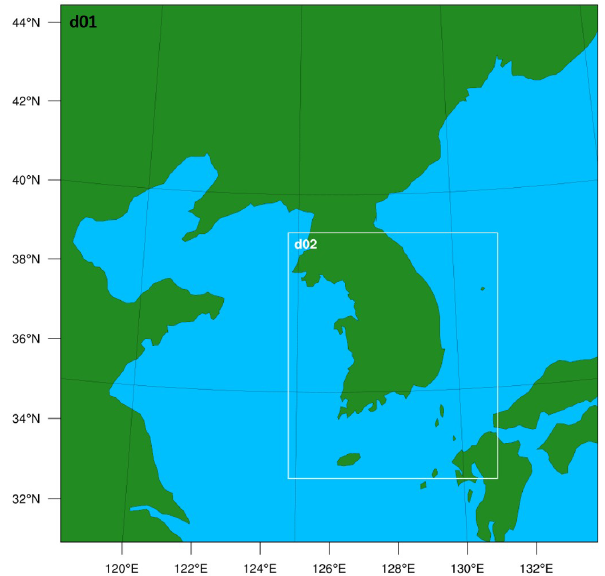
Figure 2. WRF nested domains – Domain 1 (d01) and Domain 2 (d02); d01 is centered at 38 ◦ N and 126 ◦ E in the Lambert confor- mal conic